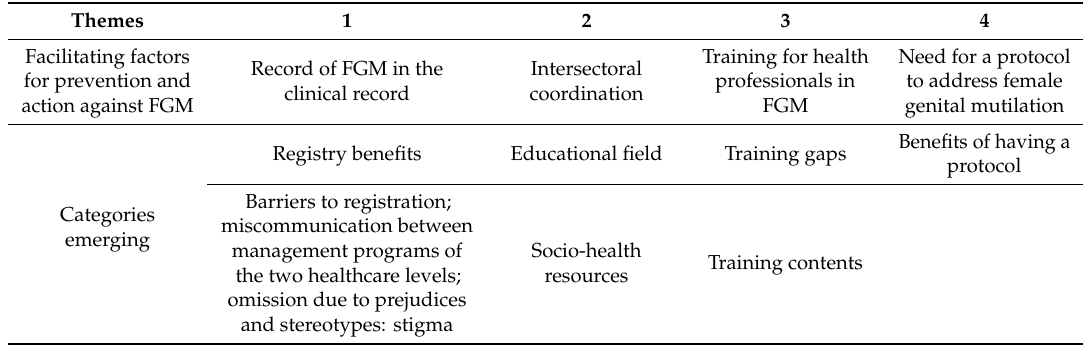
Table 3. Themes and categories identified after thematic